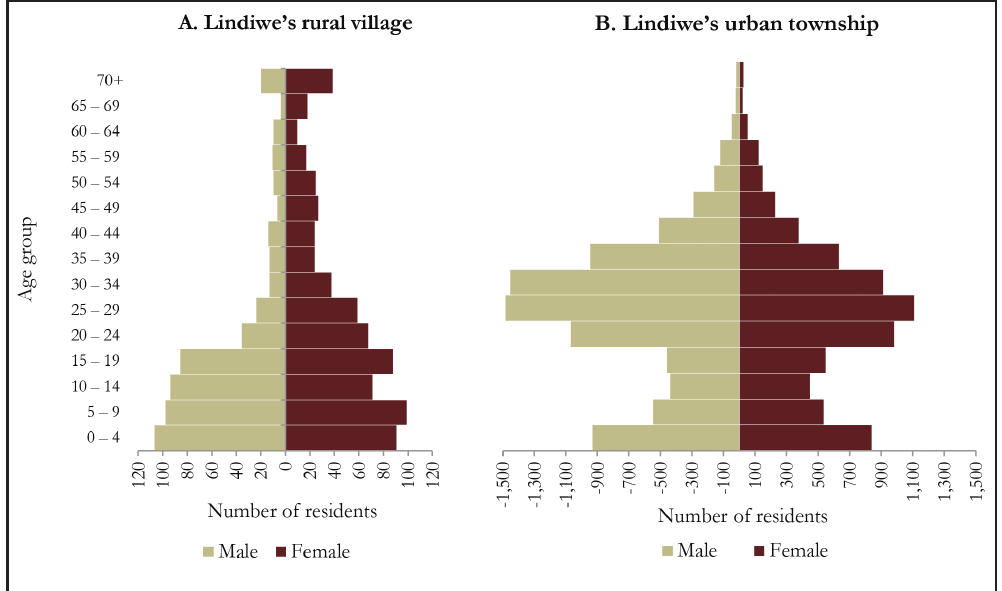
Figure 2 Population pyramids for the rural and urban